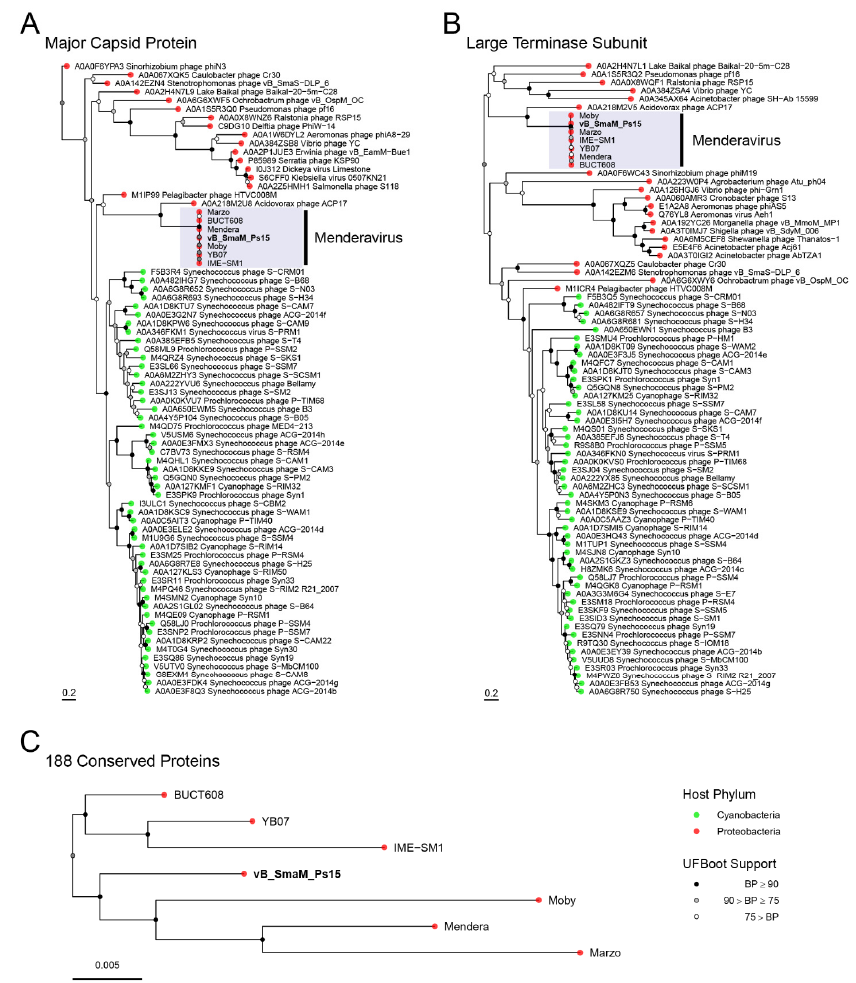
Figure 10. Phylogenetic trees showing the placement of Ps15 in respect to other phages. Phylogenies are based on the major capsid protein ( A ), the large terminase subunit ( B ), and on the partitioned phylogenomic analysis with 188 core proteins ( C ). Tip colours indicate the phylum of the host. Trees were rooted using non-reversible substitution models.